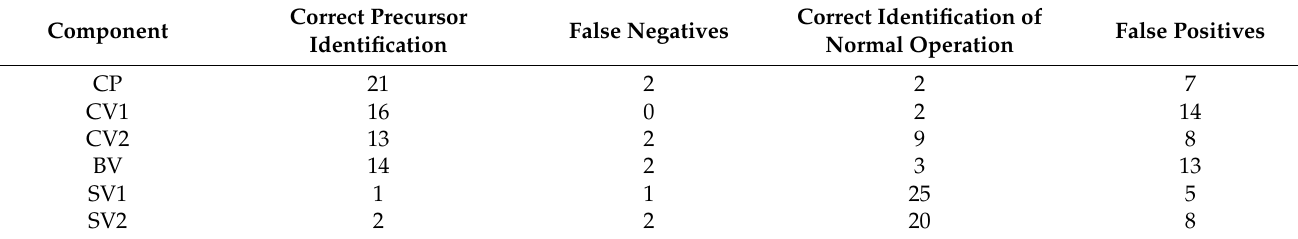
Table 3. Results of the precursor identification approach for the 32 scenarios with LOFA.